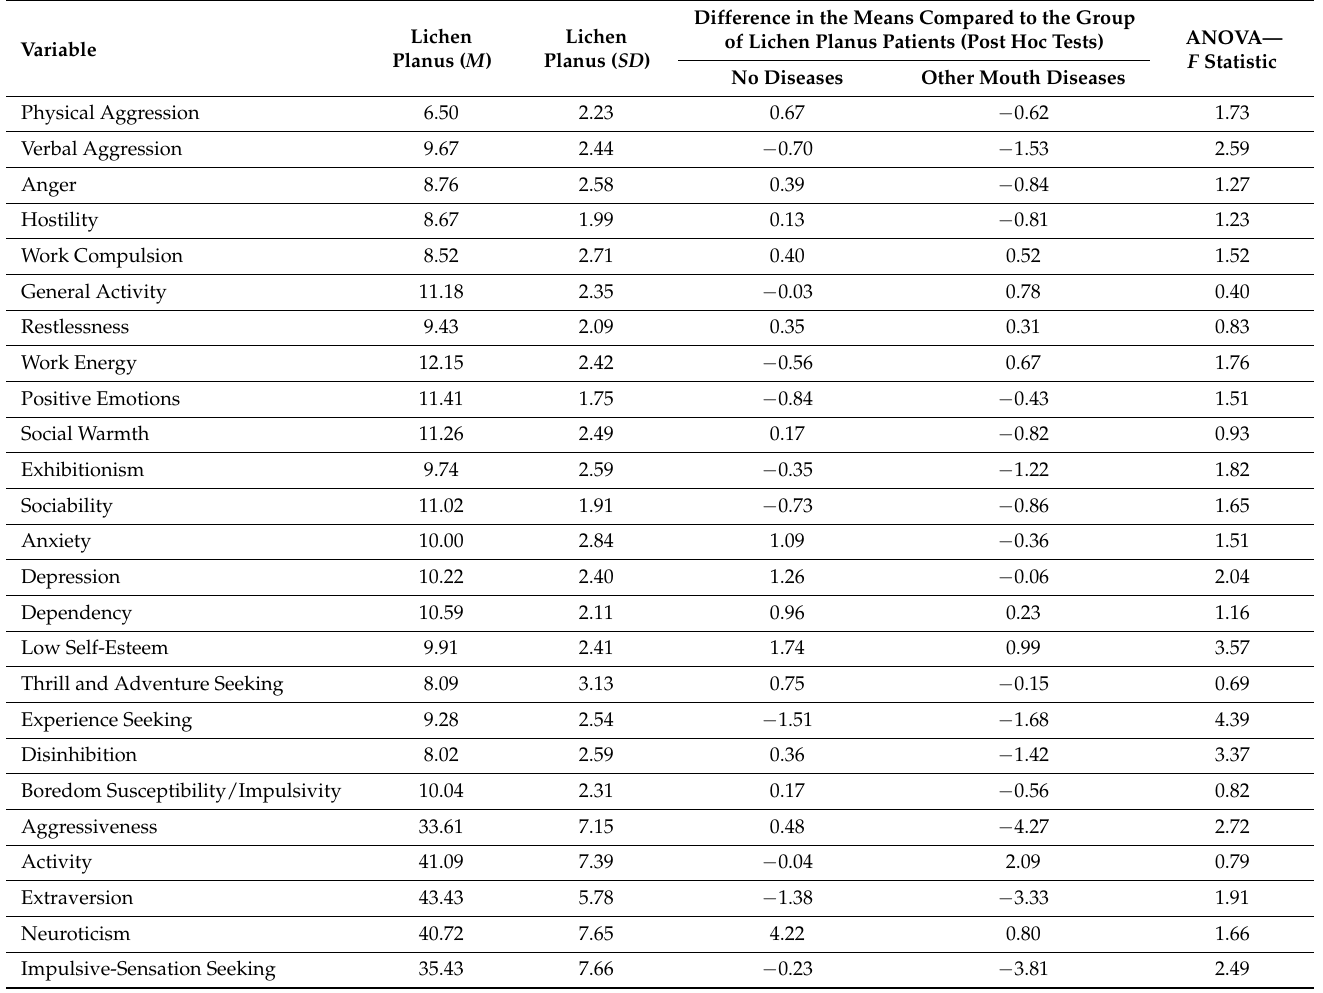
Table 2. Comparison of the mean results of patients with lichen planus with results of other respondents—dimensions of